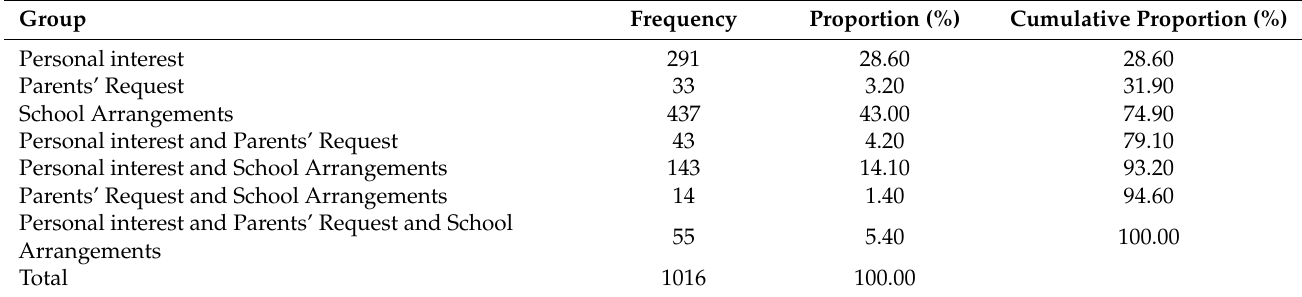
Table 5. Details of students’ choice on “Why use AI for